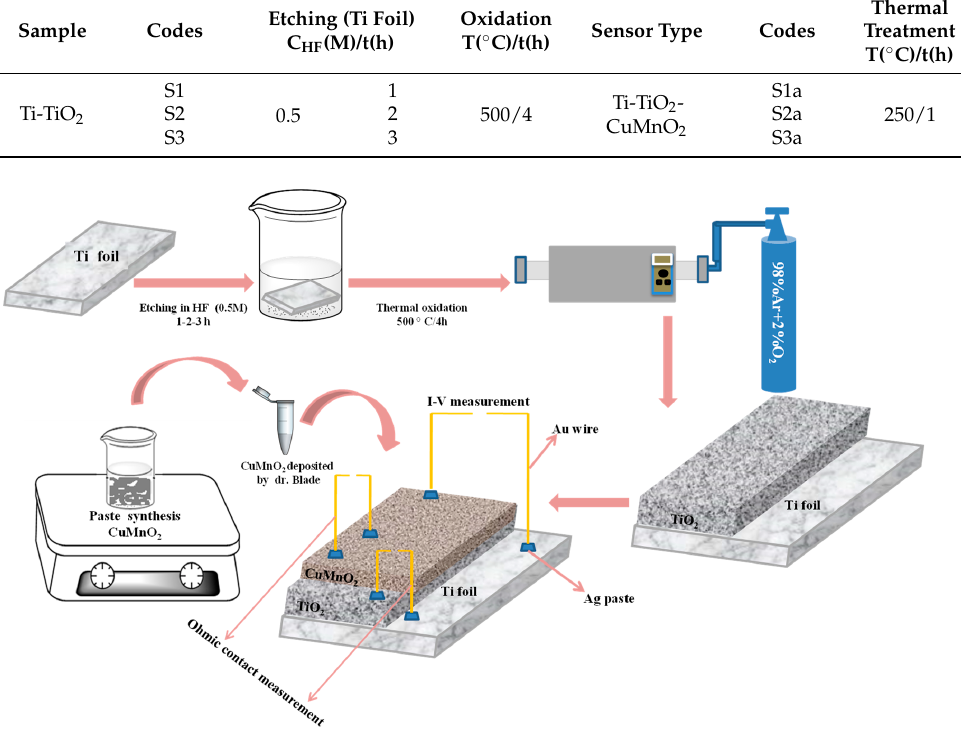
Table 1. The sample codes according to the synthesis conditions.